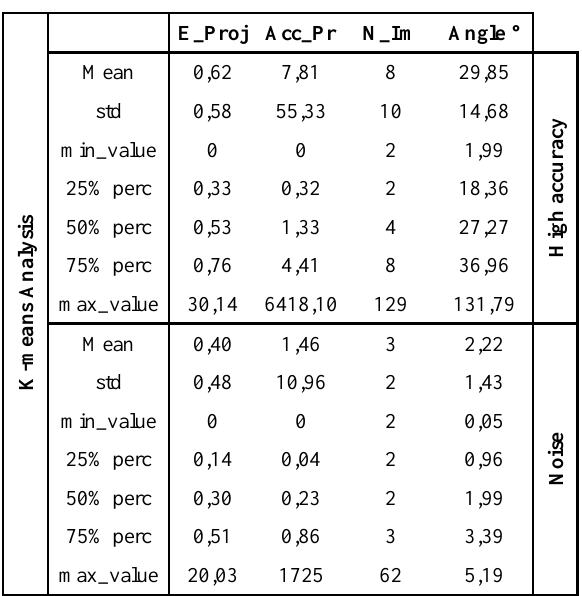
Table 2. K-means clustering: feature parameter